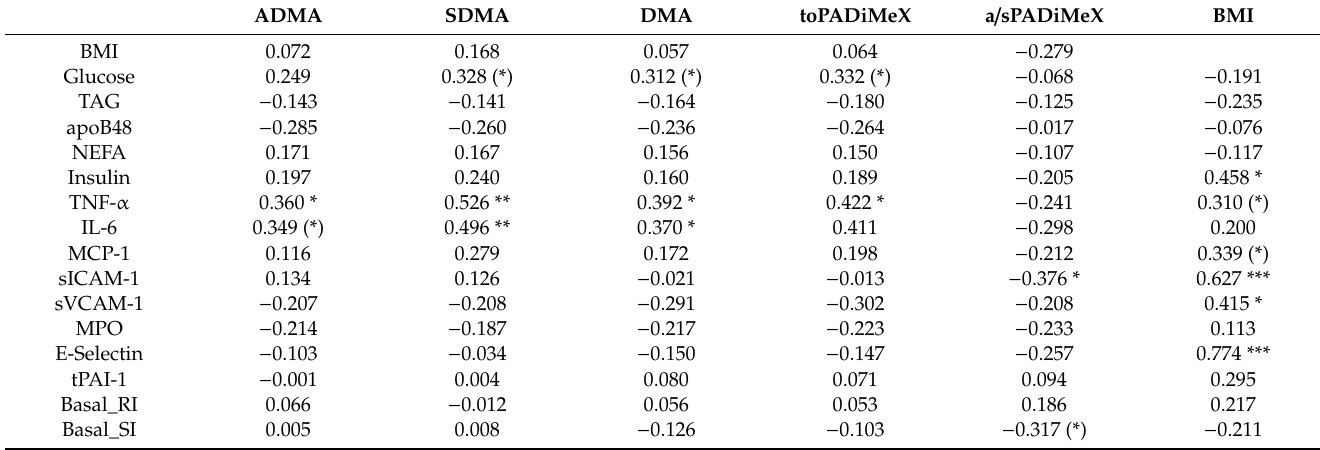
Table 3. Spearman correlation coe ffi cients between baseline urinary concentrations ( µ mol / L; not corrected for creatinine) of ADMA, SDMA, DMA, toPADiMeX, and a / sPADiMeX, BMI, and plasma clinical chemistry biochemical parameters. Data are not shown for correlations among the plasma parameters (i.e., from Glucose to Basal_SI). (*), 0.05 < p < 0.1; *, p < 0.05; **, p < 0.001; ***, p <